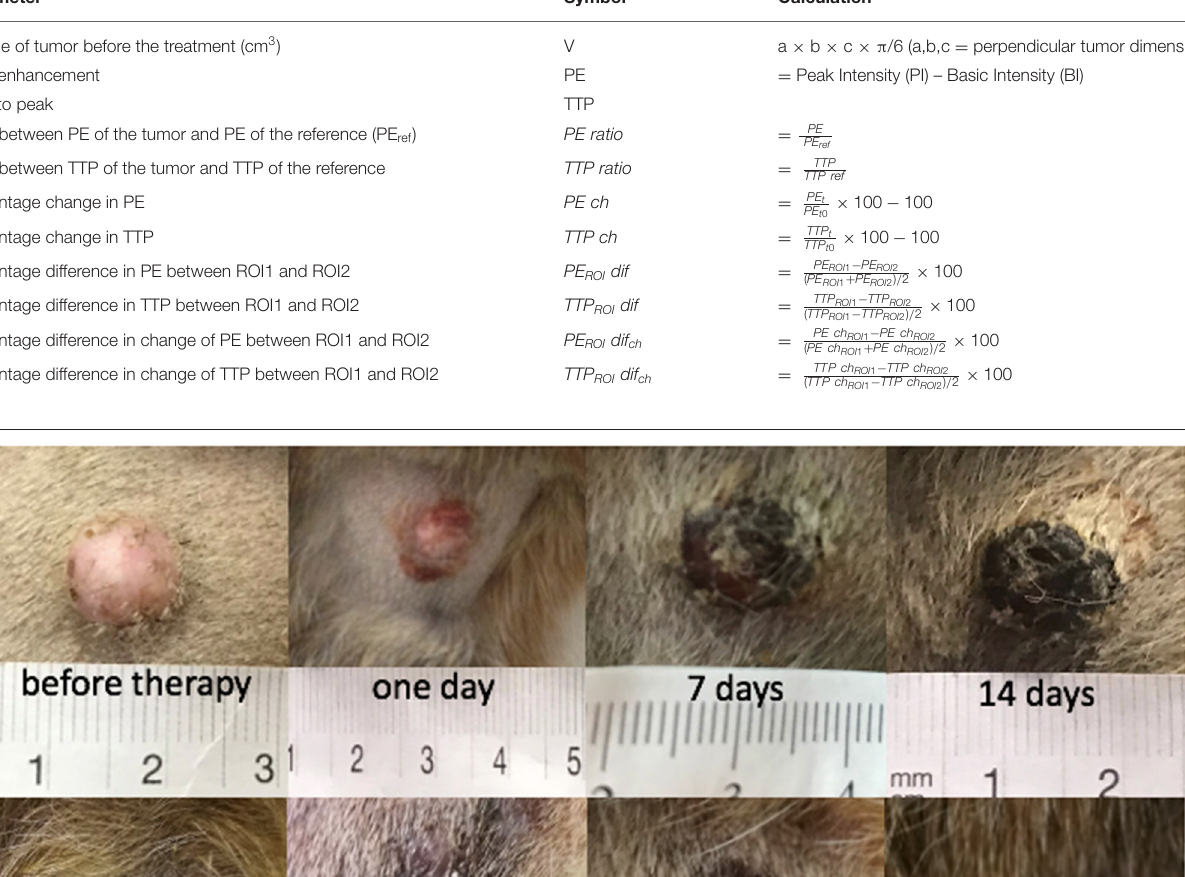
TABLE 3 | Definition of tumor volume and dynamic contrast-enhanced ultrasound parameters (DCE-US) and their calculation. Parameter Symbol Calculation